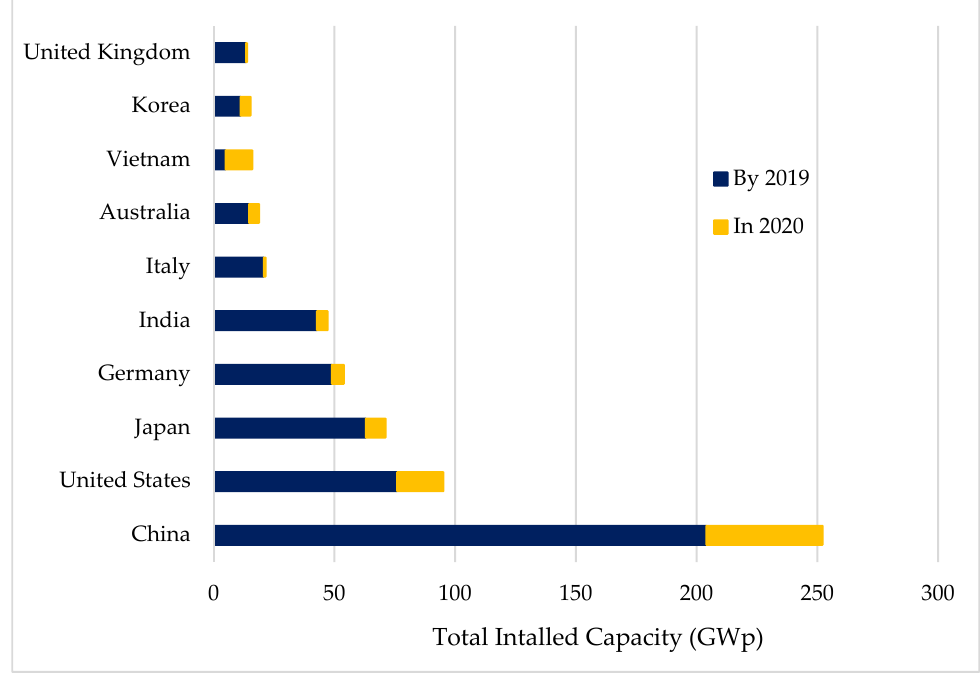
Figure 2. Total installed capacity of solar PV in top countries by 2020. Reprinted with permission (Adapted from Refs.